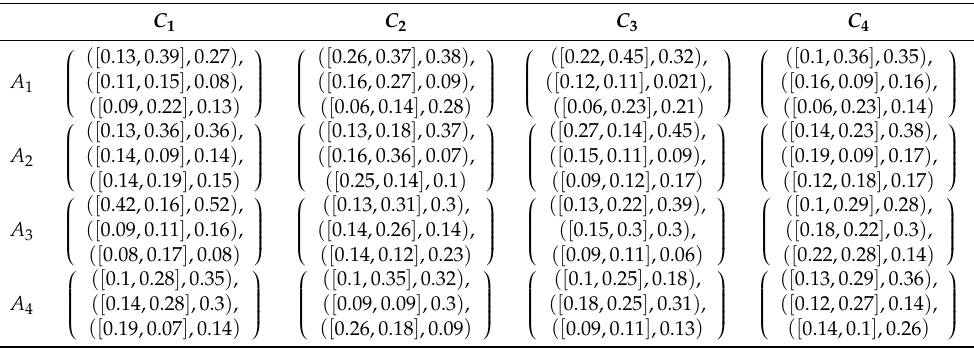
Table 4. Aggregation of all decision-maker data by the spherical cubic fuzzy Hamacher weighted average (SCFHWA) operator. C 1 C 2 C 3 C